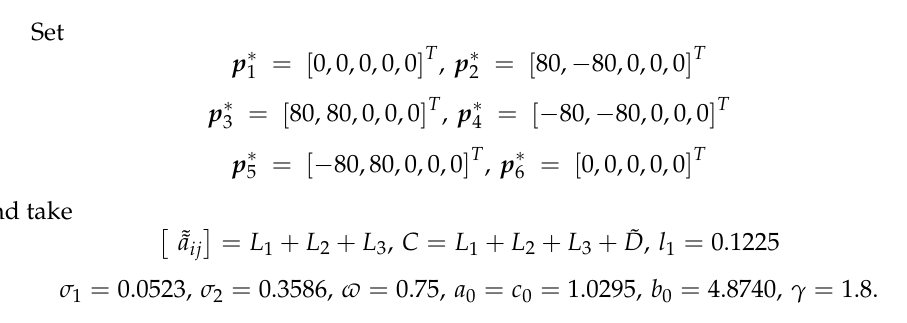
Figure 3. The network topology